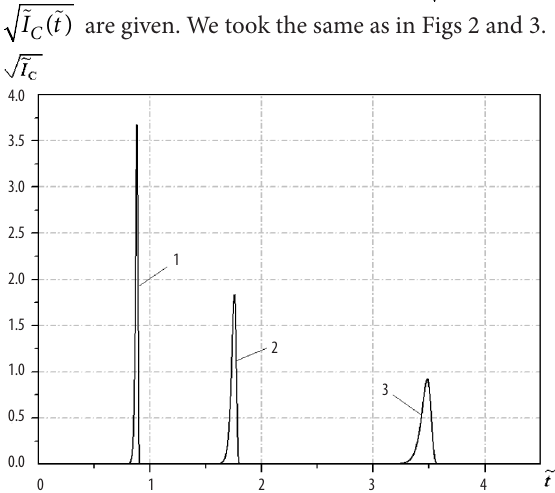
Fig. 5. Dependence of change of the effective amplitude of acoustic emission ( ) C I t   of x 6 10 − during time on different values of speed of the load’s application χ for summarizing of displacements. Values of 0 1/ χτ : 1 – 0 1/ χτ =100 000; 2